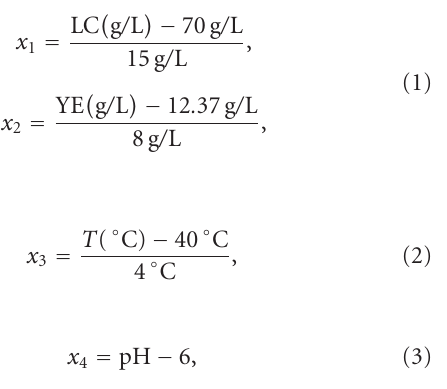
⎡ ⎤ x 1 x ⎢ ⎥ 2 ⎣ ⎦ is the . . . x k ⎡ ⎤ b 1 b ⎢ ⎥ 2 ⎣ ⎦ is the parameters . . . b k